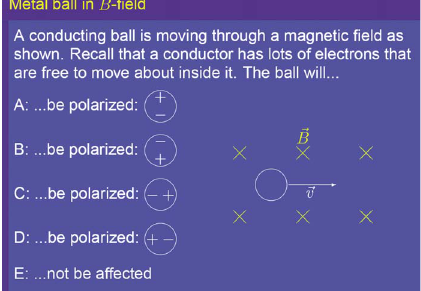
FIG. 5. (cid:1) Color (cid:2) Screen shot of a conceptual CQ in Green’s classroom (cid:1) correct answer: A